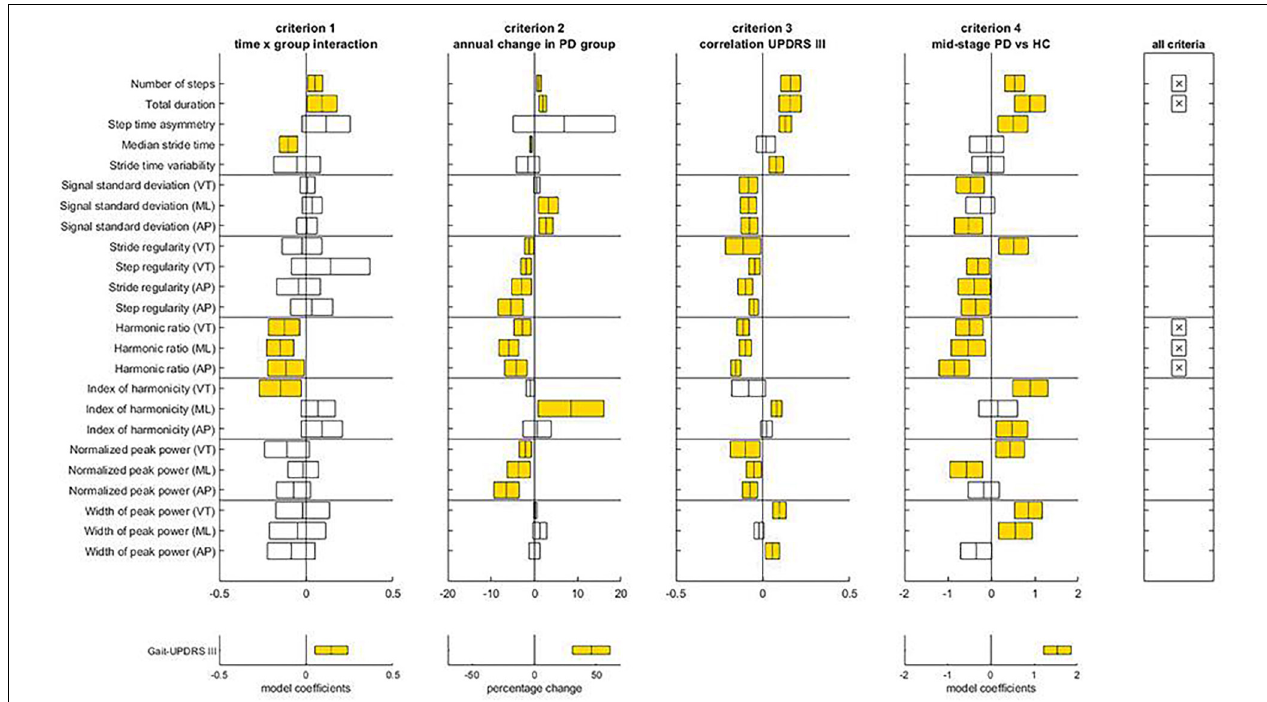
FIGURE 2 | Assessment of the criteria to identify progression makers in Early-PD. For each gait feature, means and confidence intervals of model coefficients for the interaction of time and group, for the percentage of annual change in the Early-PD, for the model coefficient of the regression to gait-UPDRS III scores, and for the model coefficient for group in the Mid-PD vs HC comparison are presented. The right panel indicates which features satisfy all four criteria. The lower panels provide results for the gait-UPDRS III scores as a reference. Note the difference in x-axis scale for percentage annual changes of gait features and gait-UPDRS III scores.